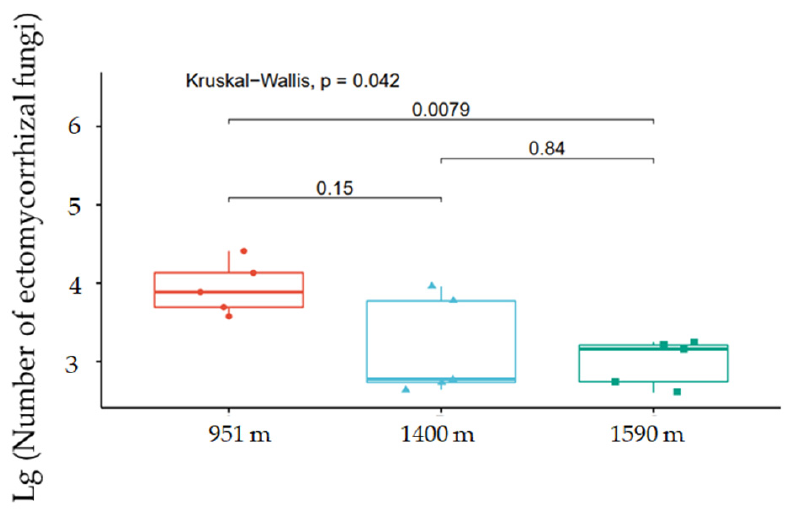
Figure 6. Differences in the number of ectomycorrhizal fungi in Abies beshanzuensis at different al- titudes.